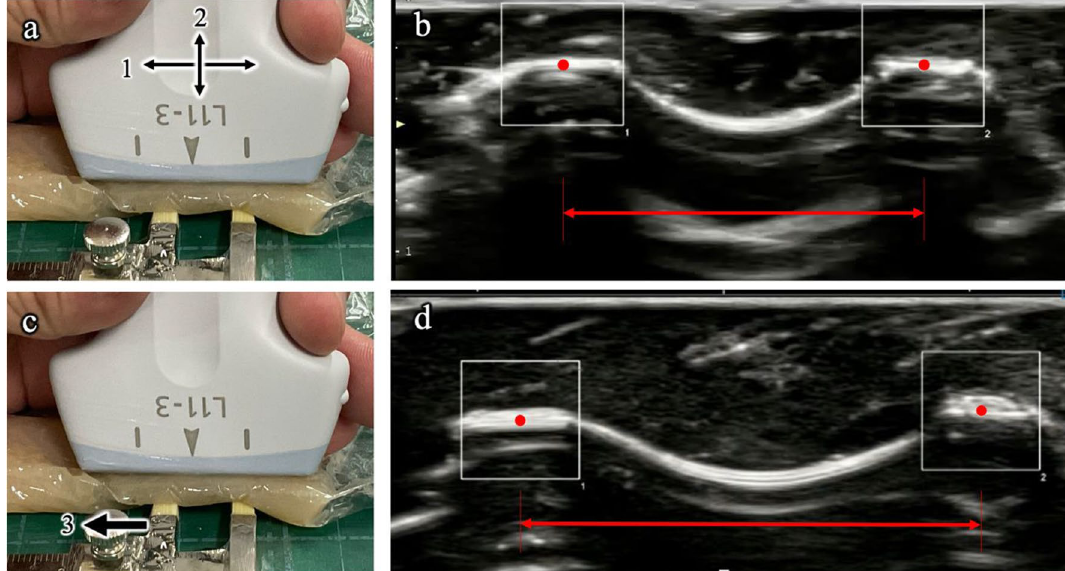
Figure 1. Setup of the reliability examination and ultrasound imaging. ( a ) Lateral (Task 1) and near-far (Task 2) probe movements along the 10-mm caliper distance using a chicken fillet as an intervening substance. ( b ) The red double arrow is the distance between two points of the region of interest (ROI) (small, white circles). ( c ) The caliper is expanded by 5 mm to 15 mm and then manually returned to 10 mm (Task 3). ( d ) The red double arrow is the distance between two points of the ROI, tracking the expansion of the caliper to 15